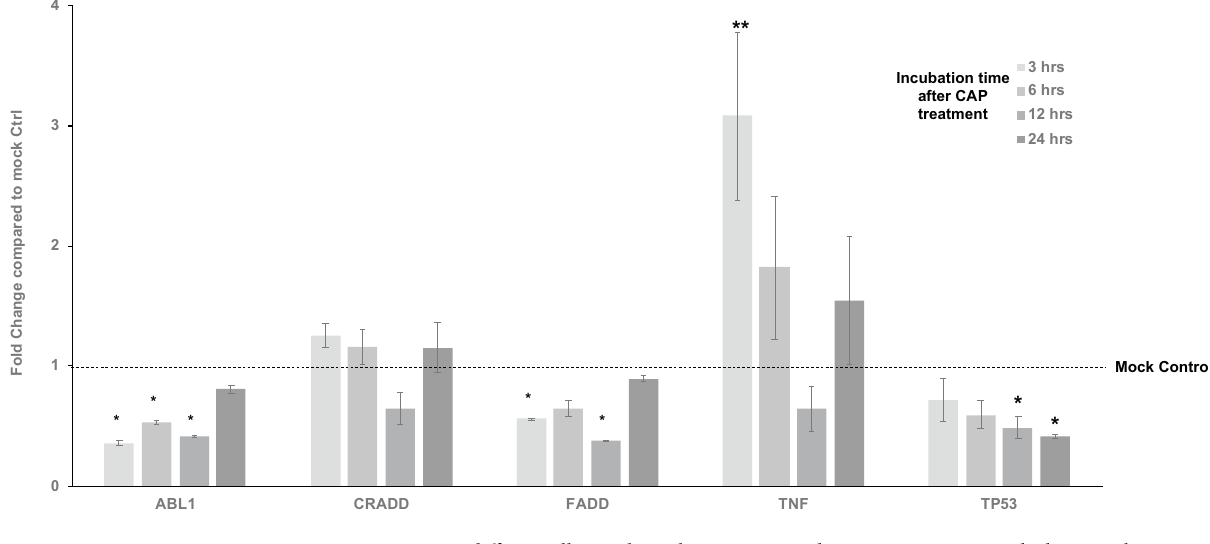
Figure 1. CHCP treatment differentially regulates the apoptosis induction genes. Bar graph showing the differential gene expression of genes involved in the induction of apoptosis after CHCP treatment in TNBC cell line MDA-MB-231. The samples were normalized to 18s rRNA and the fold changes were compared to mock controls. Error bars represent means ± SEM. Student t test significant at *p values < 0.05, **p values <